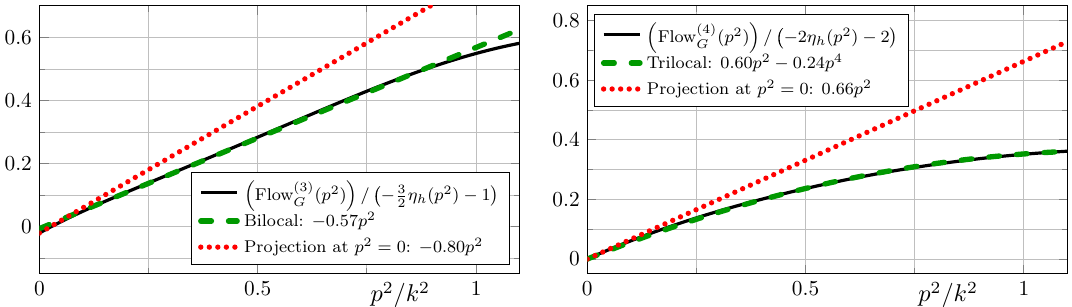
Fig. 6 Fitofalocalmomentumprojectionat p 2 = 0 tothemomentum the local momentum projection does not capture the correct momen- tum dependence in the whole momentum range 0 ≤ p 2 ≤ k 2 since it dependence of the flow of the graviton three-point function (left) and η ( p 2 ) − n + 2 ) the graviton four-point function (right) divided by ( − n is sensitive to local momentum fluctuations. Furthermore, it is techni- h 2 cally very challenging to project on the p 4 -term due to IR singularities. as defined in (26). The flows are evaluated at (μ,λ 3 ,λ 4 , g 3 , g 4 ) = = λ = λ = g = g ( − 0 . 4 , 0 . 1 , − 0 . 1 , 0 . 7 , 0 . 5 ) and λ Note again that the constant parts of the flows are irrelevant for the beta 6 3 as well as g 6 4 , 5 5 functions since they are extracted from a different tensor i.e. the same values as in Fig. 2 where a non-local momentum projec- tion was used. In comparison to the non-local momentum projection,